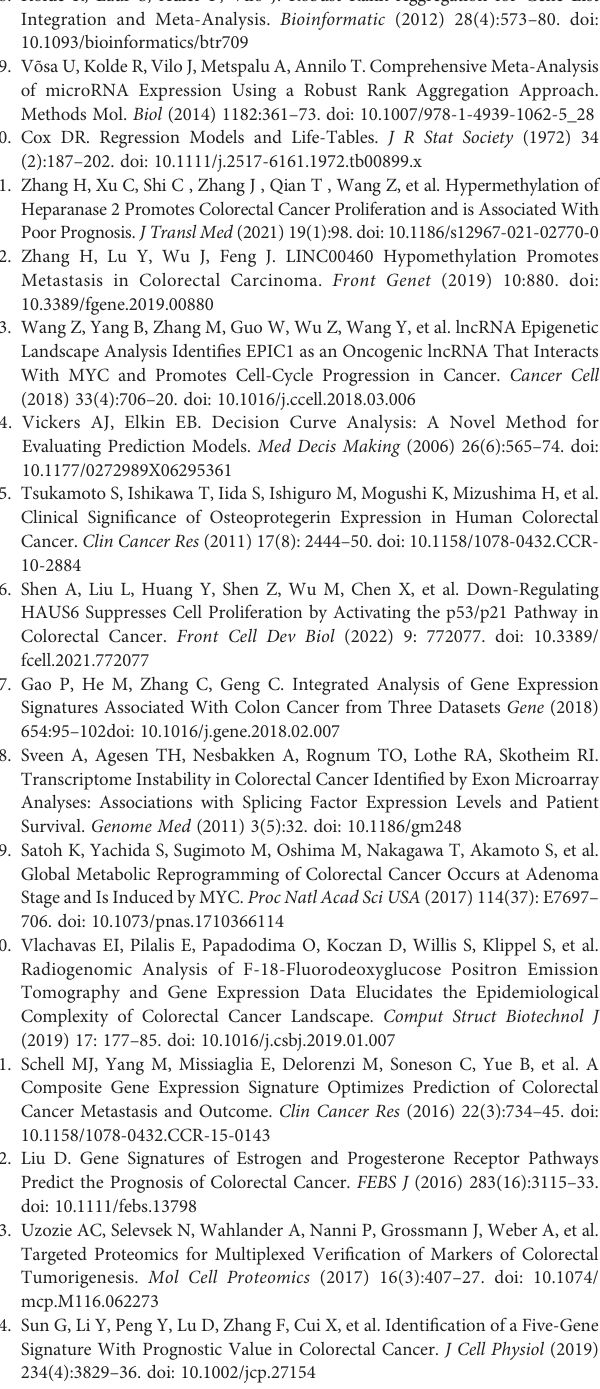
Supplementary Figure 4 | Enrichment analysis revealed the pathway associated with LEMD1. The Utility RT Pro fi ler PCR chip was used to detect changes in gene expression after LEMD1 knockdown/overexpression in SW480 and LOVO. (A) Taking the intersection, 12 genes were positively correlated with LEMD1, and 32 genes were negatively correlated. (B – D) GO enrichment analysis revealed the biological processes (B) , cytological components (C) , and molecular biological functions (D) in which LEMD1 may be